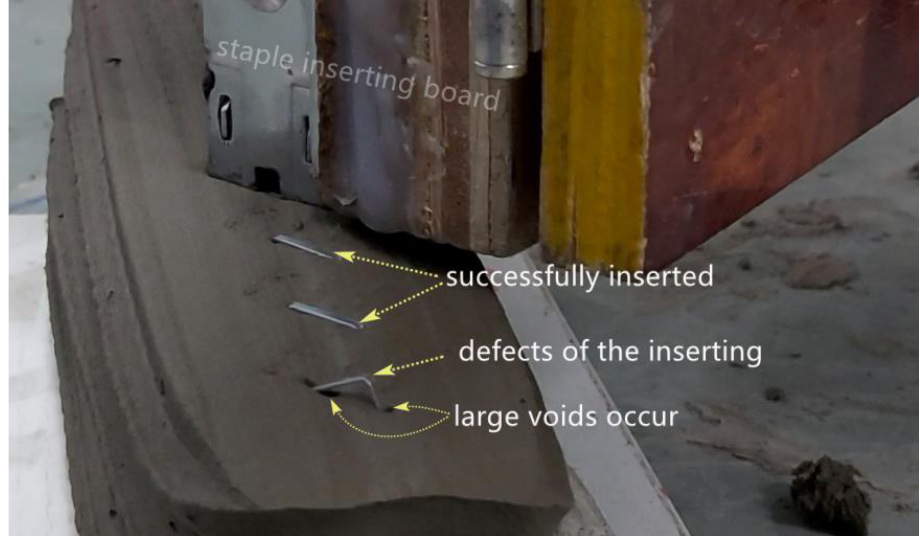
Figure 6. Quantification of the staple inserting results.